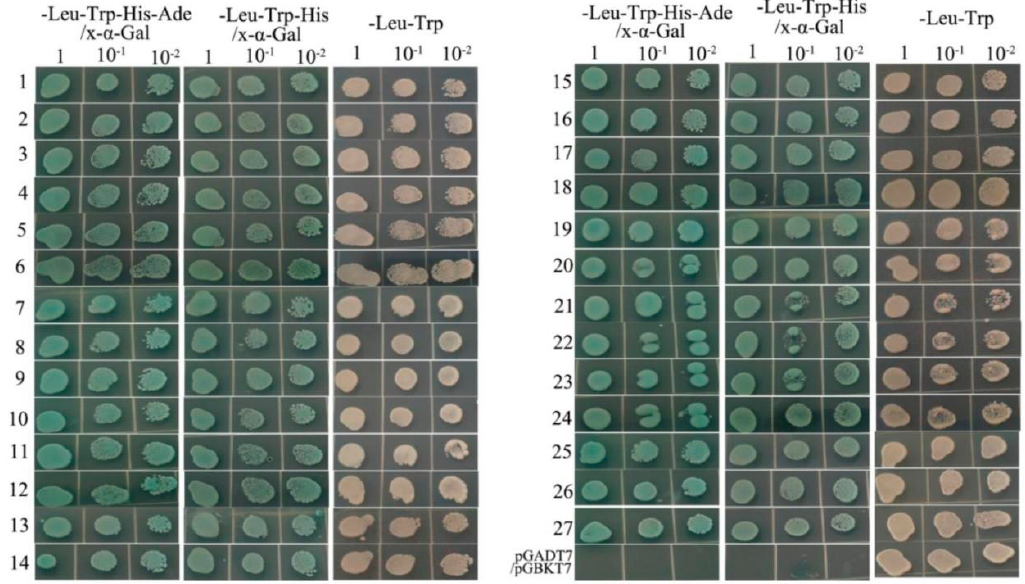
Figure 1. Interaction validation analyses of pGBKT7- IlMT2a .